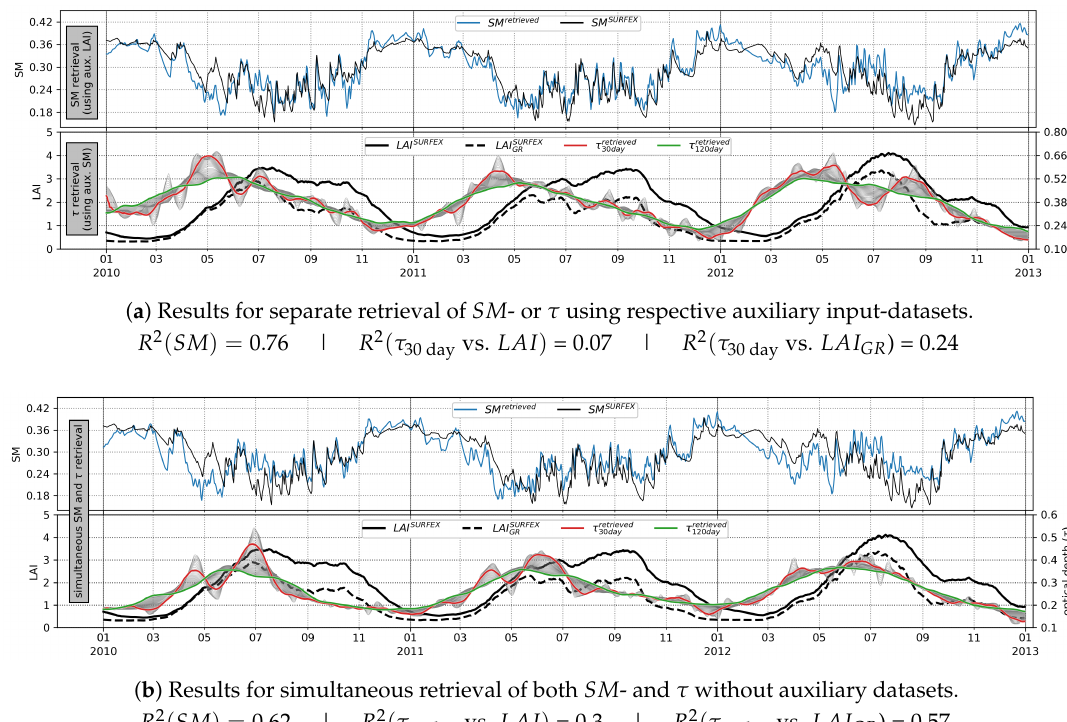
Figure 14. Retrieval results for SM - and τ in comparison to auxiliary SM - and LAI datasets. Each timeseries corresponds to a spatial average over all processed sites. The gray shading in the τ retrievals represents the variability of the results with respect to different choices of rolling-mean ) represents an LAI timeseries where value periods from 2 to 120 days. The dashed line ( LAI SURFEX GR exclusively grasslands have been